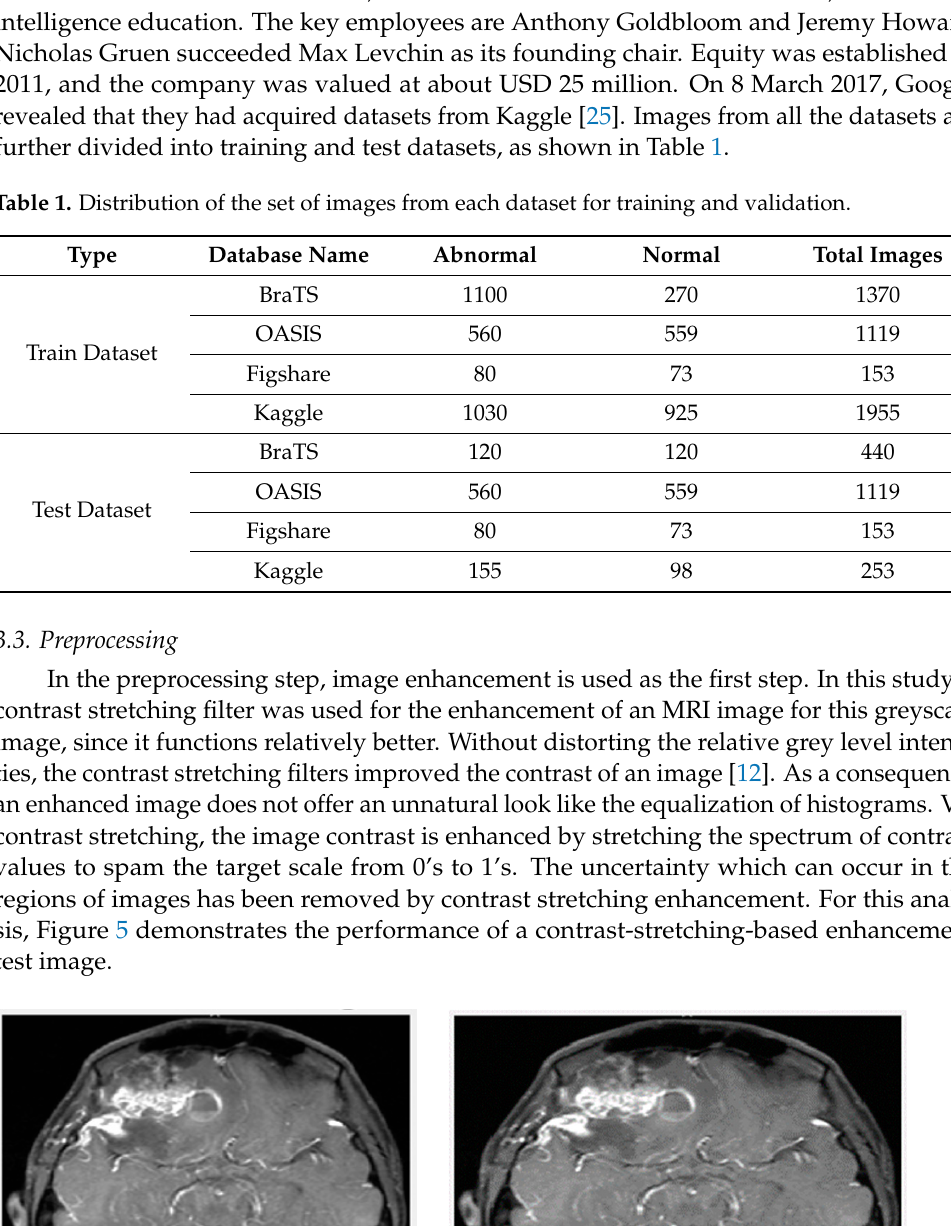
Table 1. Distribution of the set of images from each dataset for training and validation.